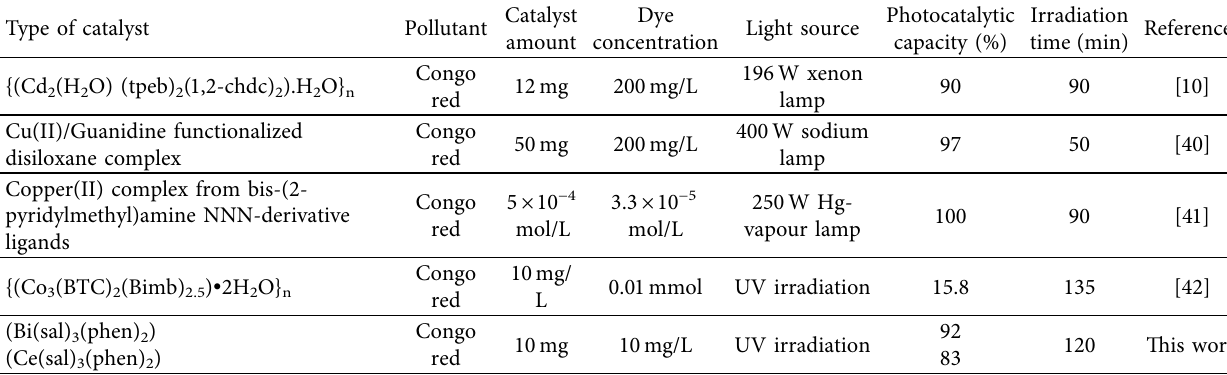
Table 1: Comparison of the photocatalytic activities of different reported complexes with the synthesized complexes against the degradation of Congo red.